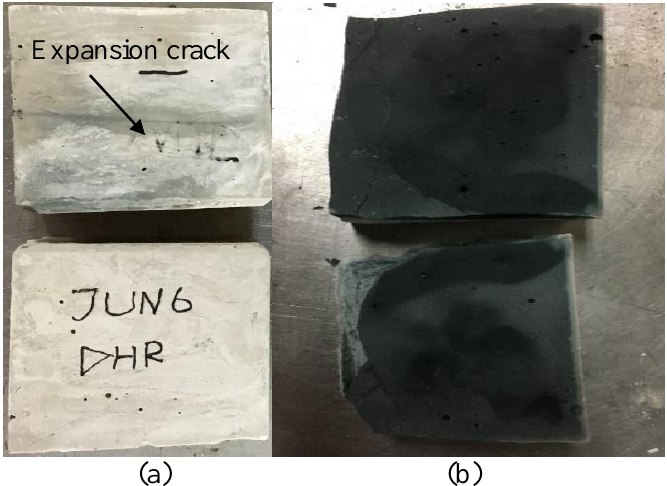
Figure 6. ( a ) Expansion crack in cube; ( b ) cracked cube pieces along the crack for mono ground granulated blast furnace slag (GGBFS) binders with reagent Na 2 SiO 3 ·5H 2 O only.